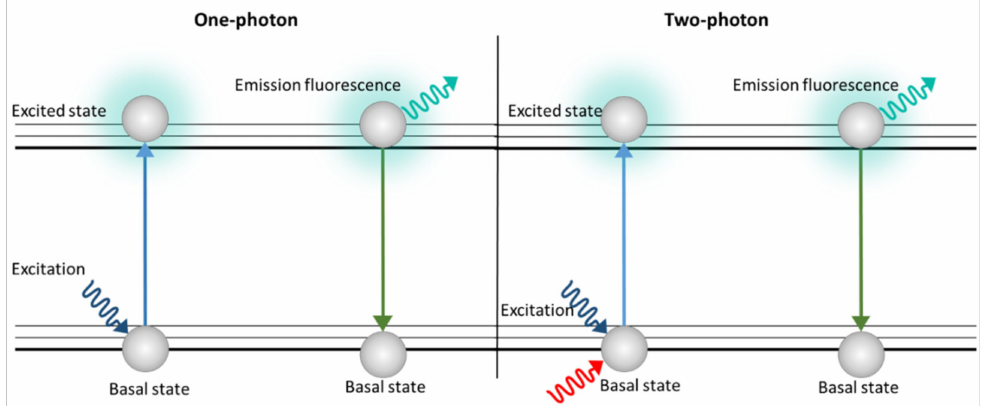
Figure 4. Schematic image of excitation with one photon (Epi, CLSM) and two photons